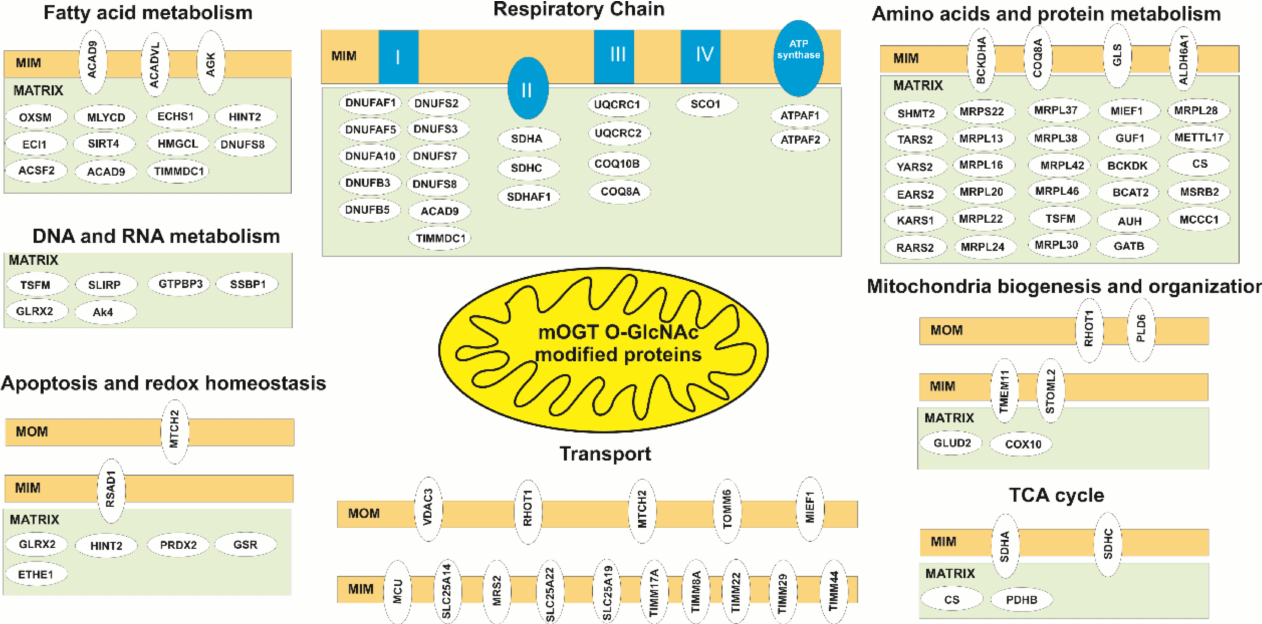
Figure 6. mOGT mediates O -GlcNAcylation of proteins involved in many processes central to mitochondria function. The circles indicate identified proteins characterized in Table S4 (Gold List). MON, mitochondria outer membrane; IMS, intermitochondria space, MIM, mitochondria inner